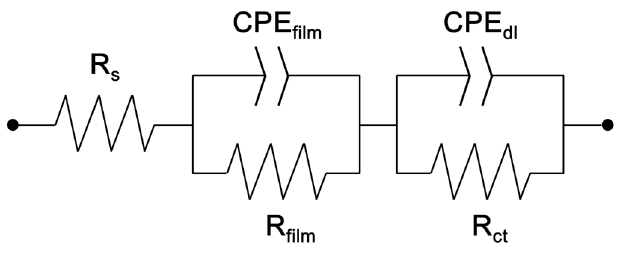
Figure 8. Electrical equivalent circuit used to fit the AC-impedance data. Table 4. Fitting parameters obtained from Figure 7a according to co-inhibitor composition.